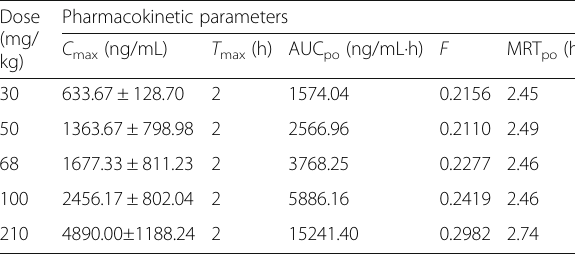
Table 2 Pharmacokinetic parameters of N-251 after oral administration in